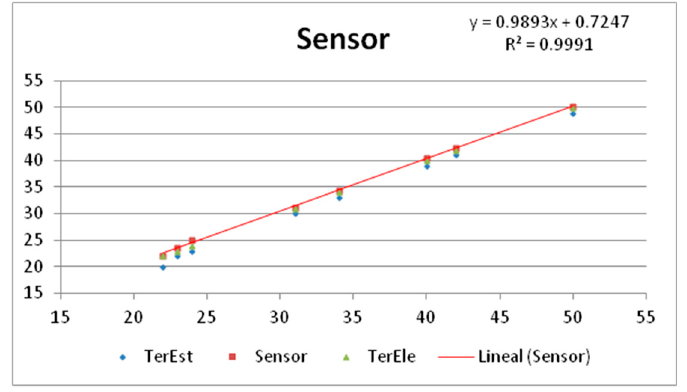
Figure 9. Calibration of a sensor with respect to the thermocouple references TerEst and TerEle.